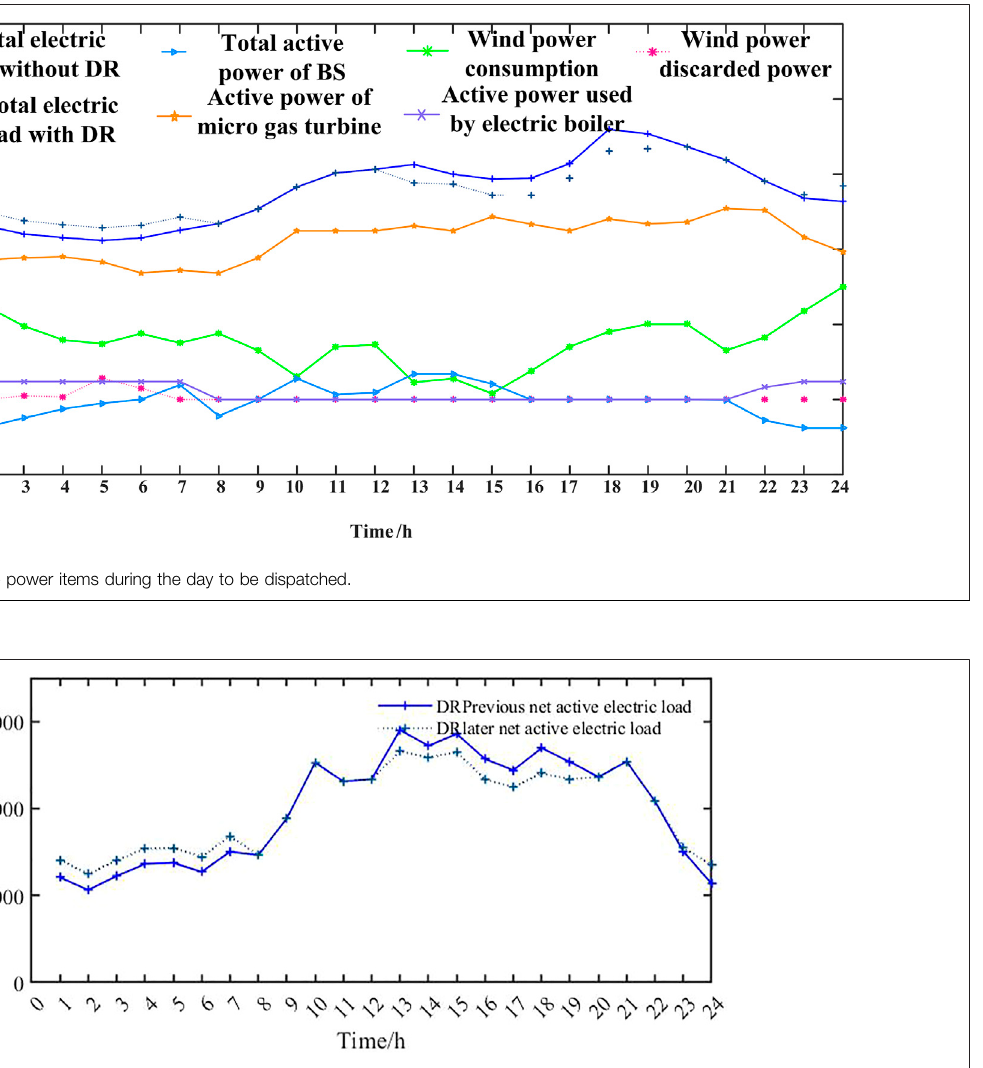
FIGURE 10 | Net active load values before and after considering demand-side response